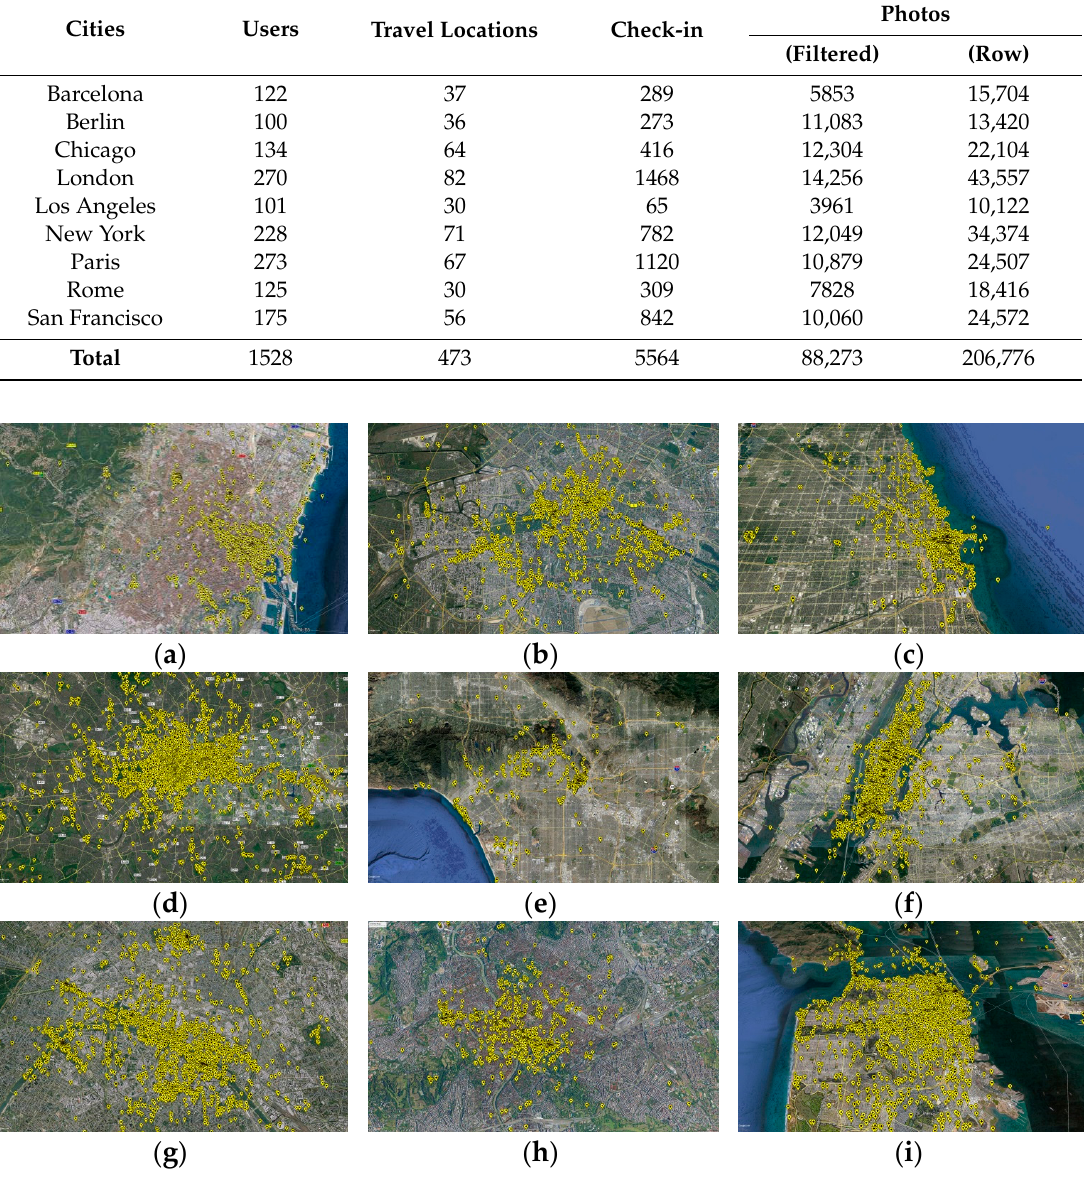
Figure 5. Spatial distribution of photos in nine popular cities worldwide: ( a ) Barcelona, ( b ) Berlin, ( c ) Chicago, ( d ) London, ( e ) Los Angeles, ( f ) New York, ( g ) Paris, ( h ) Rome, and (i ) San Francisco, mapped on Google